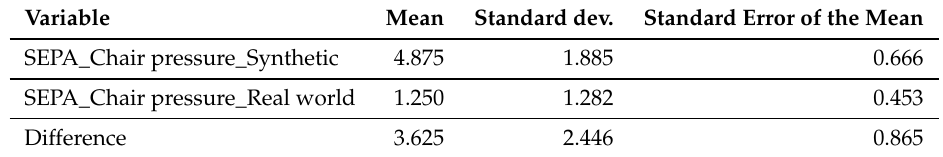
Table 4. Contrast between real and simulated SEPA in Chair pressure (ADL: Prepare breakfast).